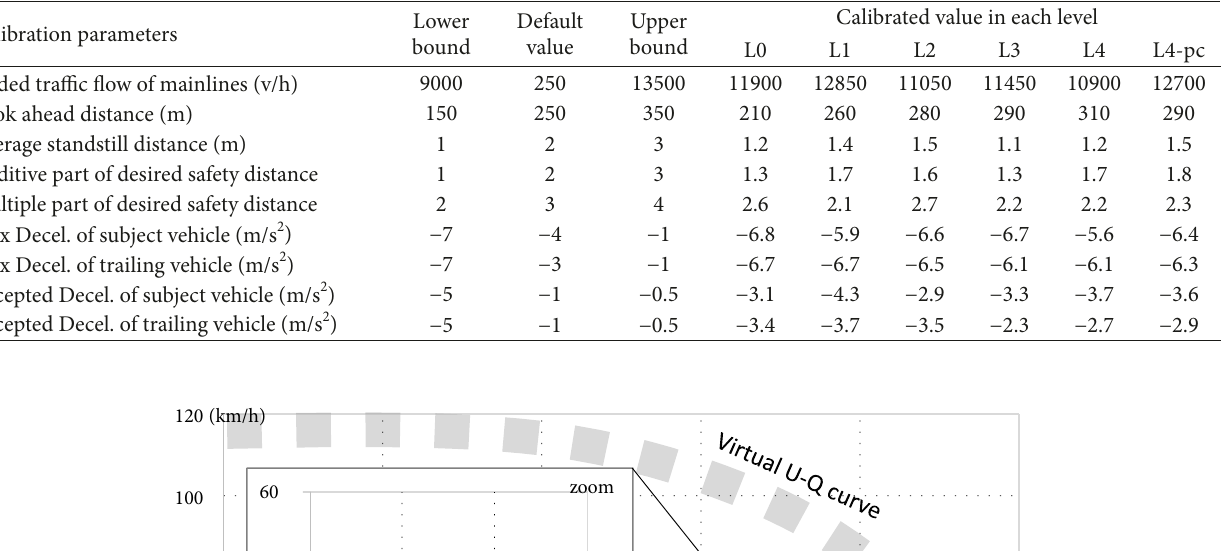
Table 3: Calibration parameters and calibrated values.